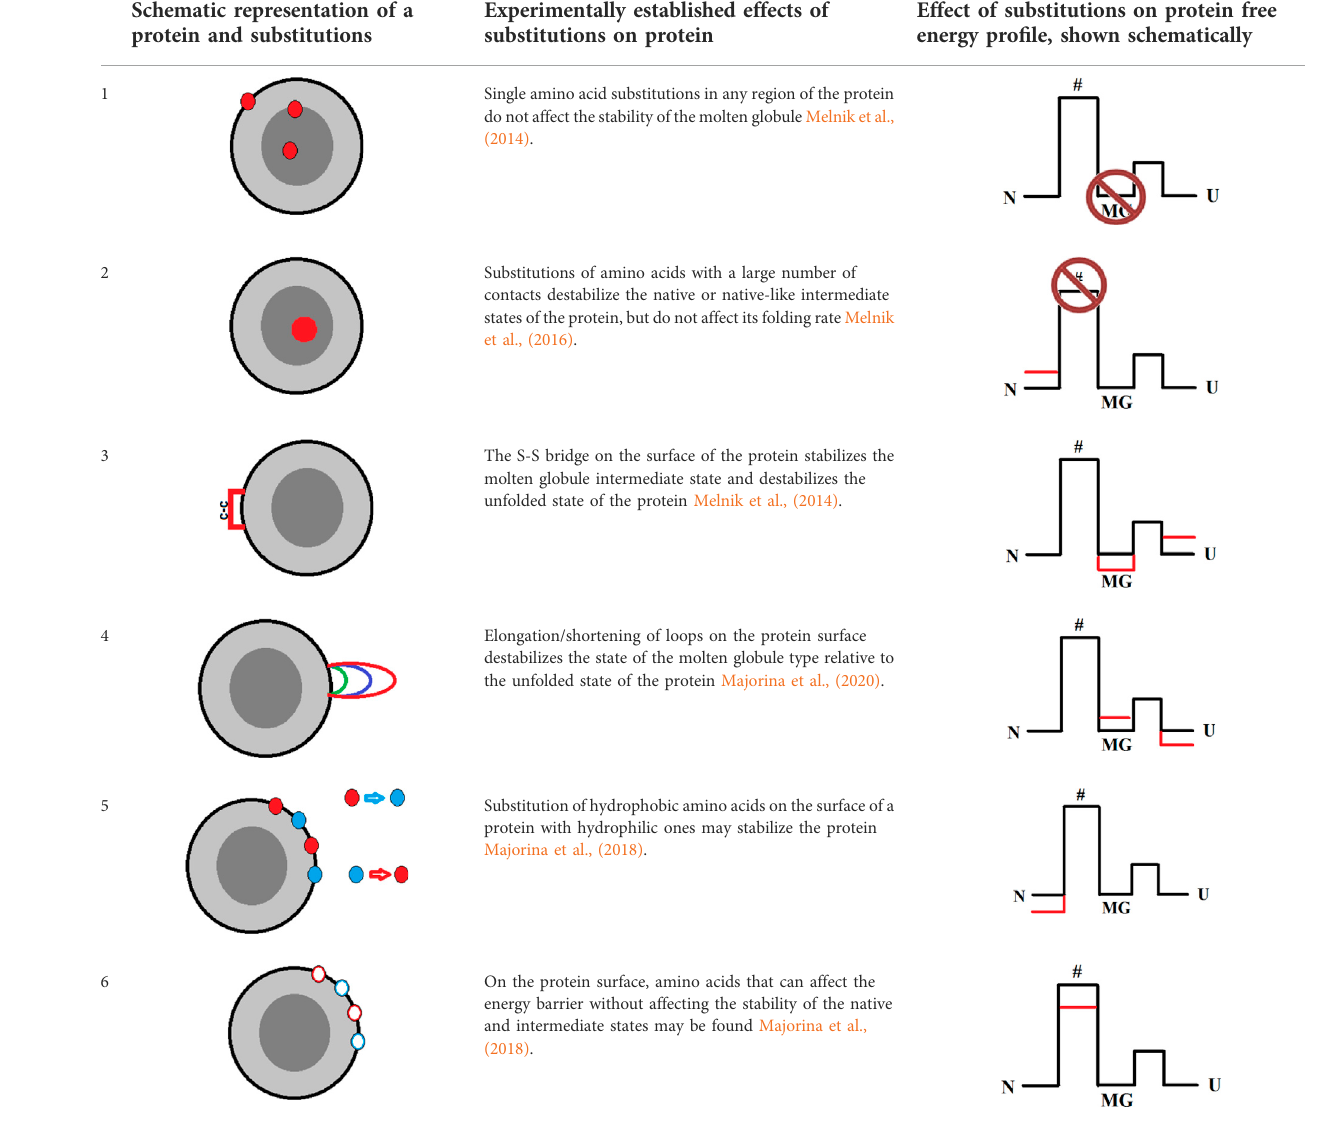
TABLE 2 Effects of amino acid substitutions on protein free energy pro fi le. Schematic representation of a protein and substitutions